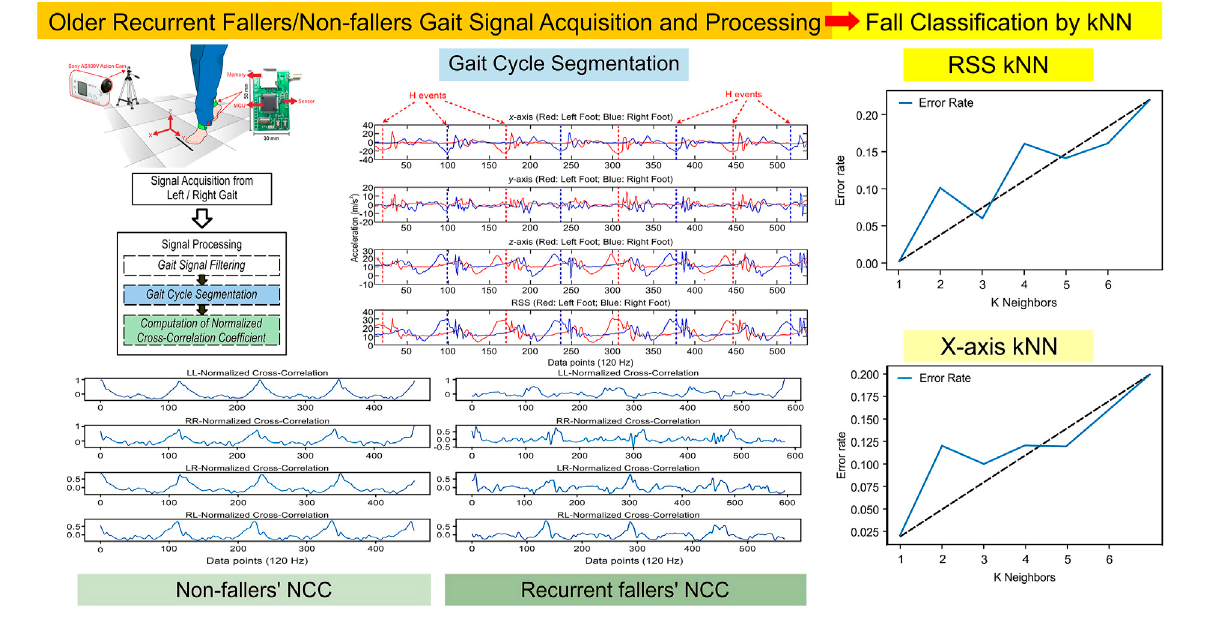
FIGURE 8 | Summary illustration of this